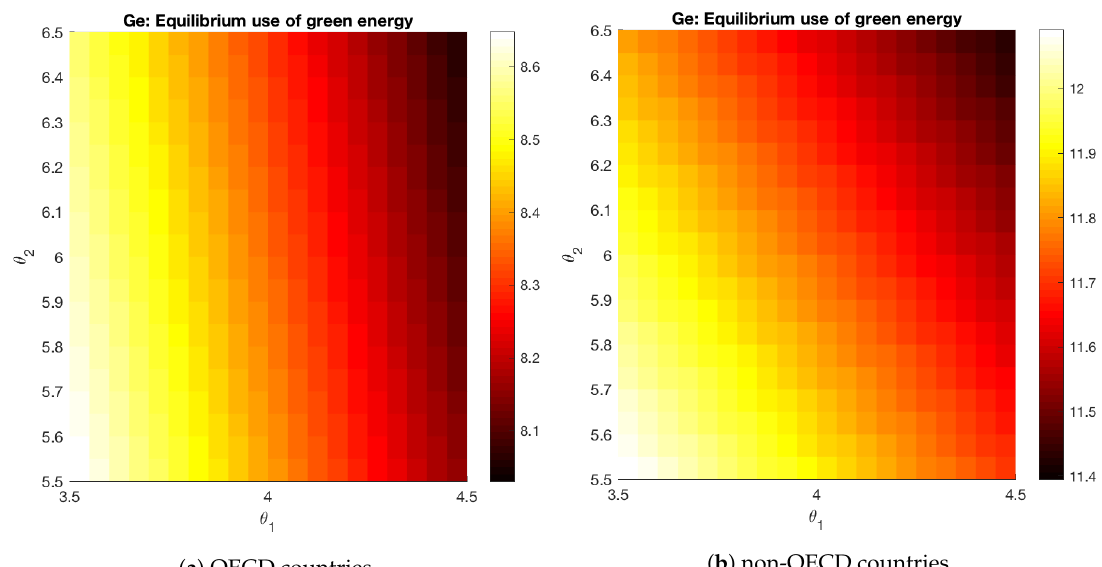
Figure 13. Equilibrium values, green energy